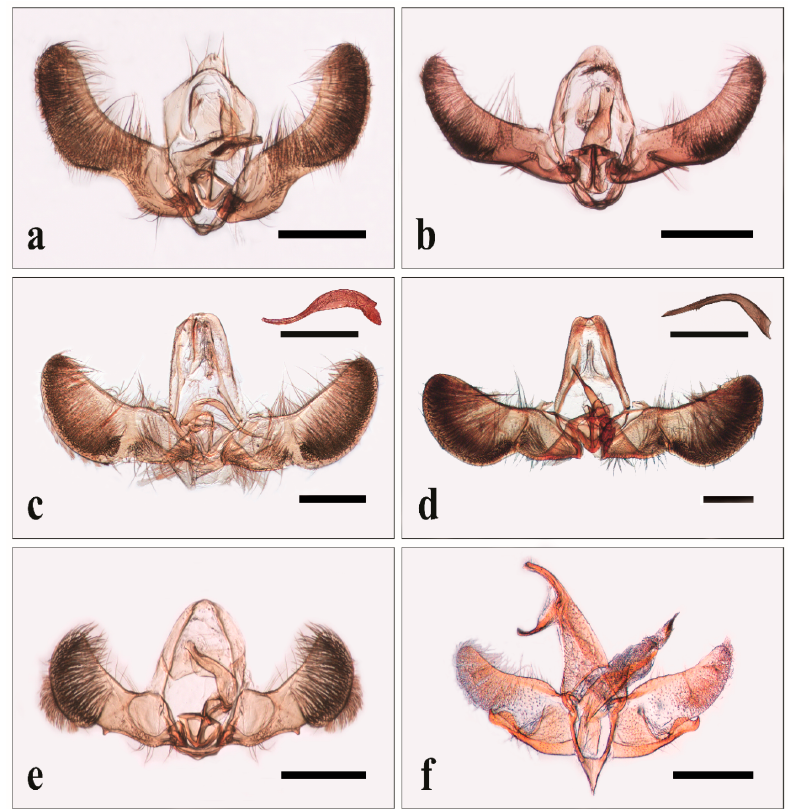
Figure 1. Male genitalia of: Pammene fasciana (L.) ( a ); P . suspectana (Lienig & Zeller) ( b ); Cydia fagiglandana (Zeller) with aedeagus in lateral view ( c ); C . splendana (Hübner) with aedeagus in lateral view ( d ); Grapholita ( Aspila ) funebrana Treitschke ( e ); Oegoconia novimundi (Busck) ( f ). Bar: 500 μ m.